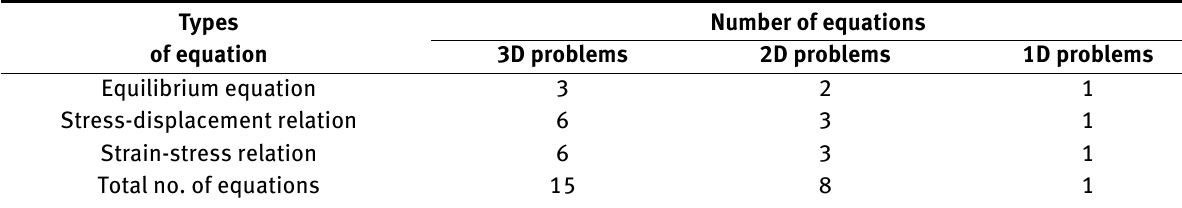
Table 3: Type and number of equations in 1D, 2D, and 3D problems [25] Types